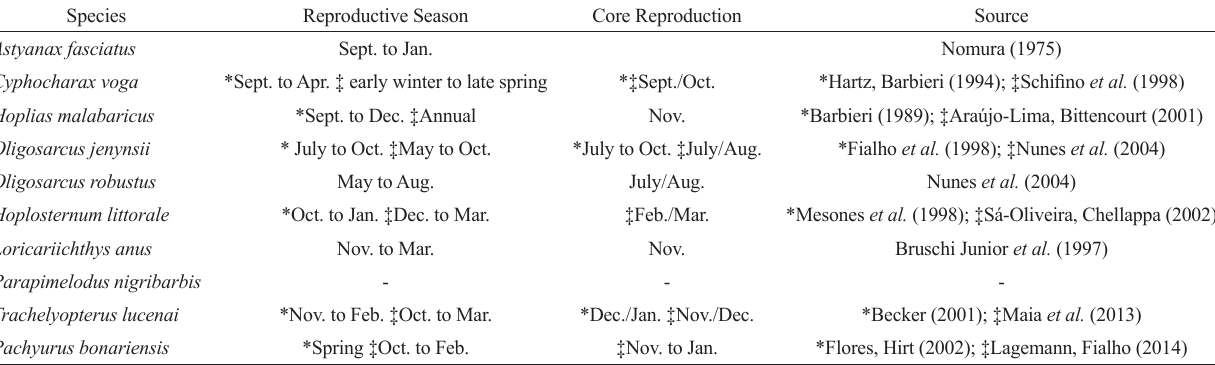
Tab. 3. Reproductive season and core reproductive period for dominant fish species in the Patos Lagoon basin, according to published data. Symbols indicate the references for